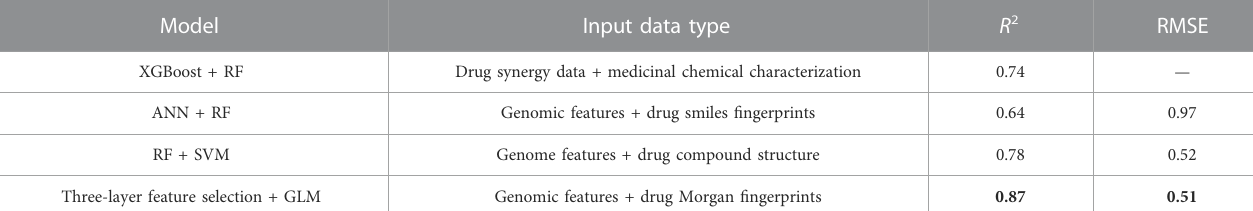
TABLE 3 Model performance comparison. The bold values indicate the best results of the models.